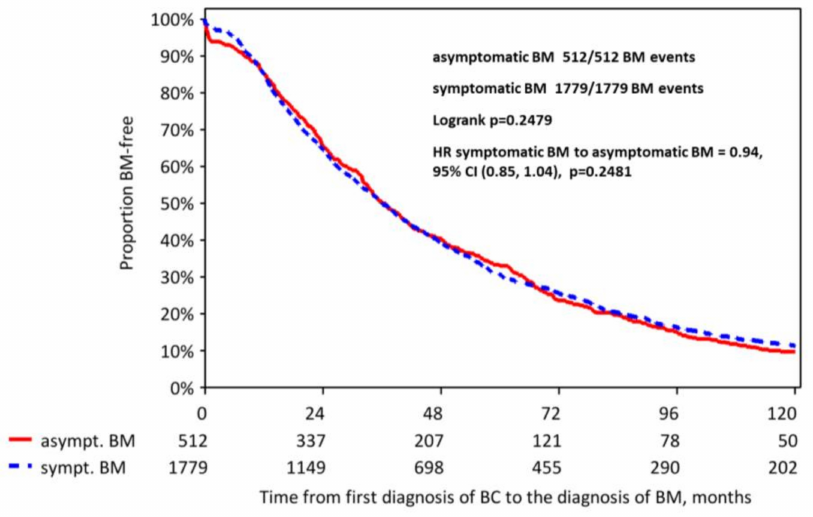
Figure 1. Kaplan-Meier curves for the time from the diagnosis of breast cancer to the diagnosis of BM. Patients with asymptomatic BM had a longer median overall survival compared to symptomatic patients (10.4 vs. 6.9 months, p < 0.001, Figure 2).